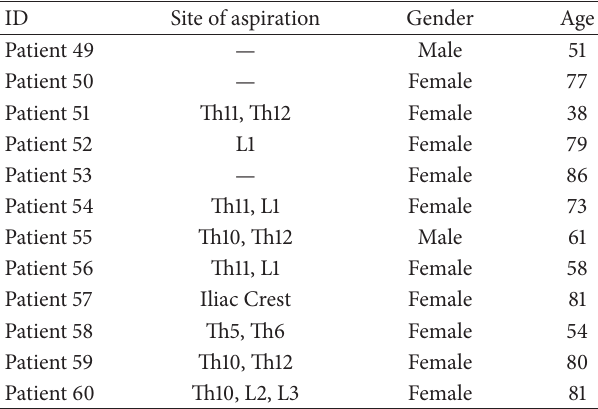
Table 1: List of donors used for hMSC expansion. All cells were obtained with ethical approval (KEK 187#10) from bone marrow aspirates of the vertebral body of patients undergoing spinal